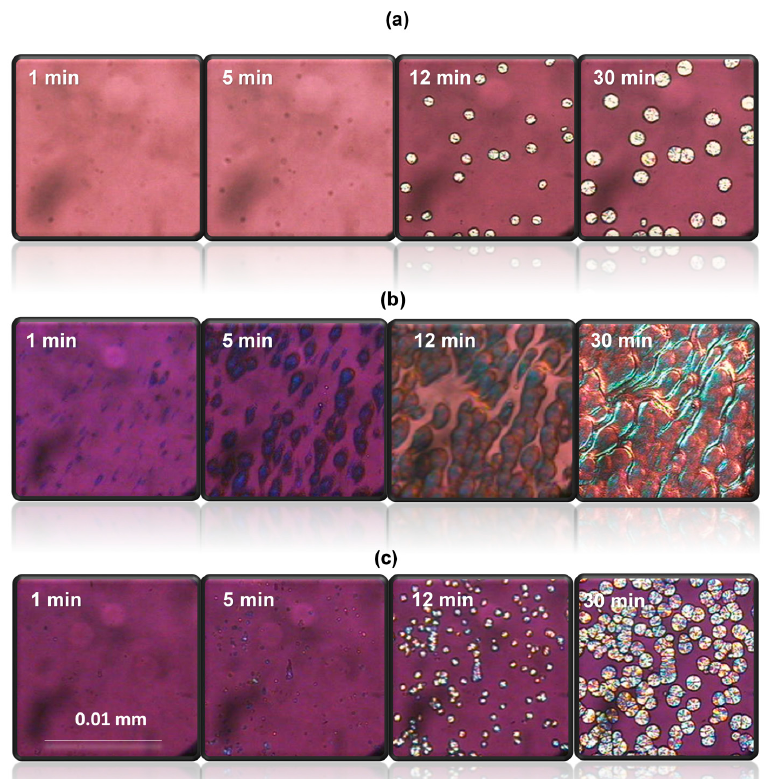
Figure 5. Polarized optical micrographs of the isothermal crystallization at 135 °C for the iPP wax–sorbitol compounds; ( a ) DBS, ( b ) MDBS, and ( c ) DMDBS, for 1 min, 5 min, 12 min and 30 min, respectively, left to right.